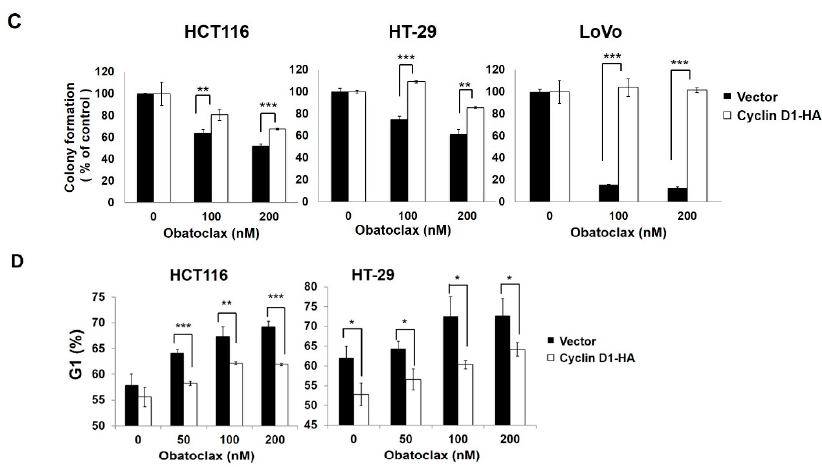
Figure 2. Obatoclax downregulates cyclin D1 to induce G 1 -phase arrest and consequent antiproliferation. ( A ) Obatoclax downregulates cyclin D1. HCT116, HT-29, and LoVo cells were exposed to obatoclax (0, 25, 50, 100, 200 nM) for 24 h, followed by cyclin D1 immunoblotting. α -Tubulin levels served as the control for equal loading; ( B ) Overexpression of cyclin D1 attenuates obatoclax-elicited reduction of cyclin D1. Stable clones of HCT116, HT-29, and LoVo cells with ectopic expression of hemagglutinin (HA)-tagged cyclin D1 were treated with obatoclax (0, 100, 200 nM) for 24 h. HA immunoblotting was performed to confirm ectopic expression of HA-tagged cyclin D1, and cyclin D1 immunoblotting was used to verify the resistance to the obatoclax-induced decrease in cyclin D1 levels. α -Tubulin levels served as the control for equal loading; ( C ) Overexpression of cyclin D1 rescues colony formation capability of obatoclax-treated cells. HA-Cyclin D1 stable clones and their corresponding vector controls were treated with obatoclax (0, 100, 200 nM) for 24 h, followed by colony formation assays. Significant restoration of colony numbers was observed in the group with overexpression of HA-Cyclin D1. Data were presented as the percentage relative to the drug-untreated control; ( D ) Overexpression of cyclin D1 abrogates obatoclax-elicited G1-phase arrest. HA-Cyclin D1 stable clones and their corresponding vector controls were treated with obatoclax (0, 50, 100, 200 nM) for 24 h, followed by cell cycle analysis to determine the levels of cell population at the G 1 -phase. A marked reduction of cells at the G 1 stage was revealed in HA-Cyclin D1 stable clones treated with obatoclax. Data were presented as the percentage relative to the drug-untreated control. *: p < 0.05; **: p < 0.01; ***: p <